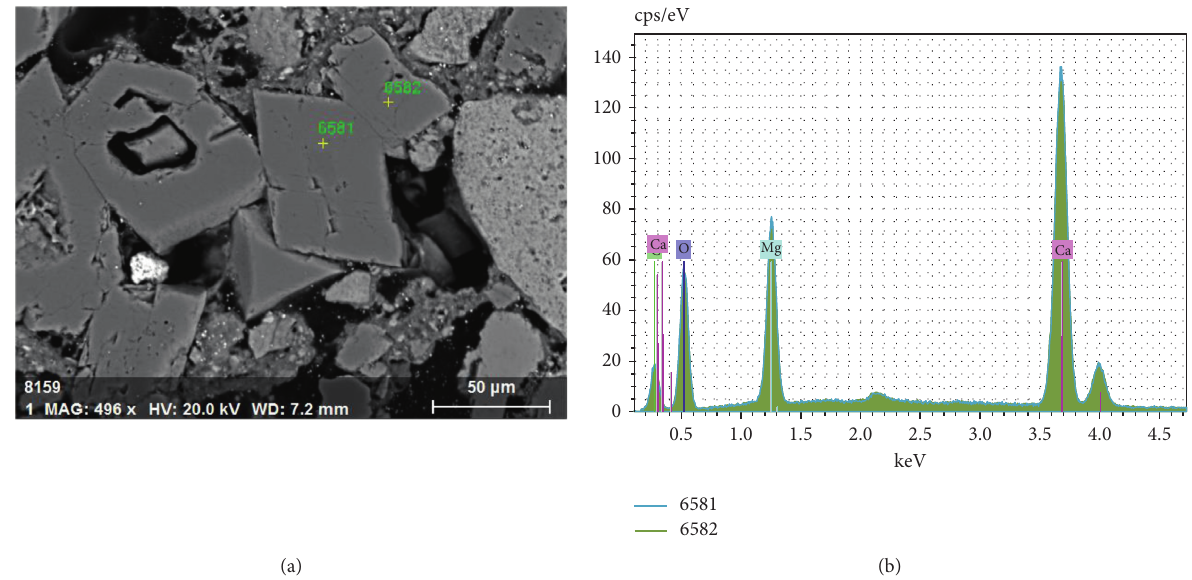
Figure 13: Backscattered electron diagram and energy spectrum image of dolomite.